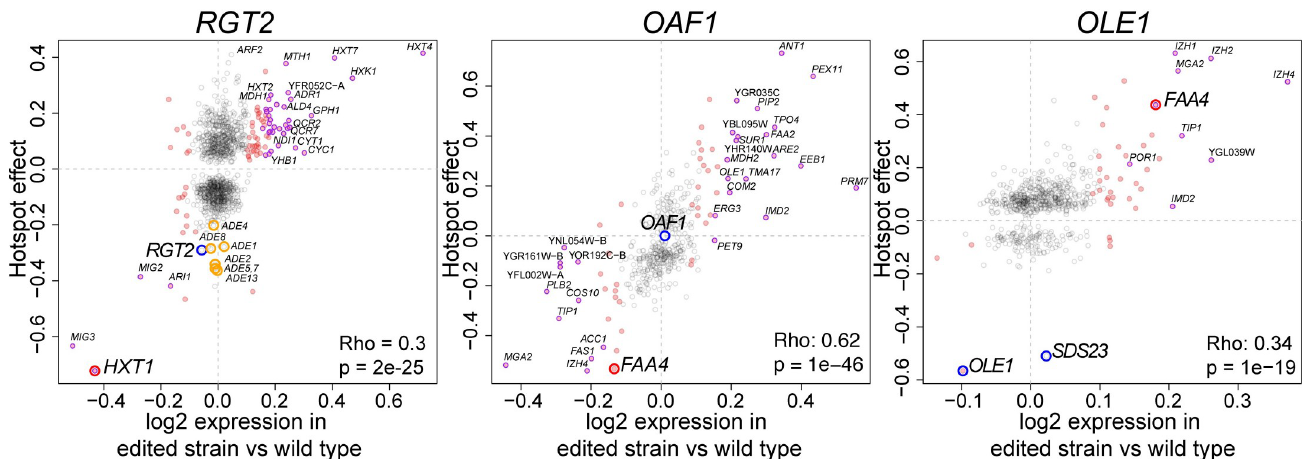
Fig 9. Comparison of the differential gene expression caused by each causal variant and the eQTL hotspot effects. The differential expression of an edited vs wildtype strain is on the x-axis and the previously determined hotspot effects are on the y-axis. Hotspot effects are coefficients from a regularized linear regression of expression values on the genotype at the respective hotspot marker [12]. Genes with non-zero hotspot effects are shown. Red points are genes with differential expression p-value < 0.05. Purple points are genes with differential expression at FDR < 0.1. The larger red circles mark the genes used for fine-mapping. The blue circles are genes we investigated in the confidence interval of each hotspot. The correlation between differential expression and hotspot effects is given in each panel. For RGT2 , orange circles show adenine-metabolism related genes that are described in the text.